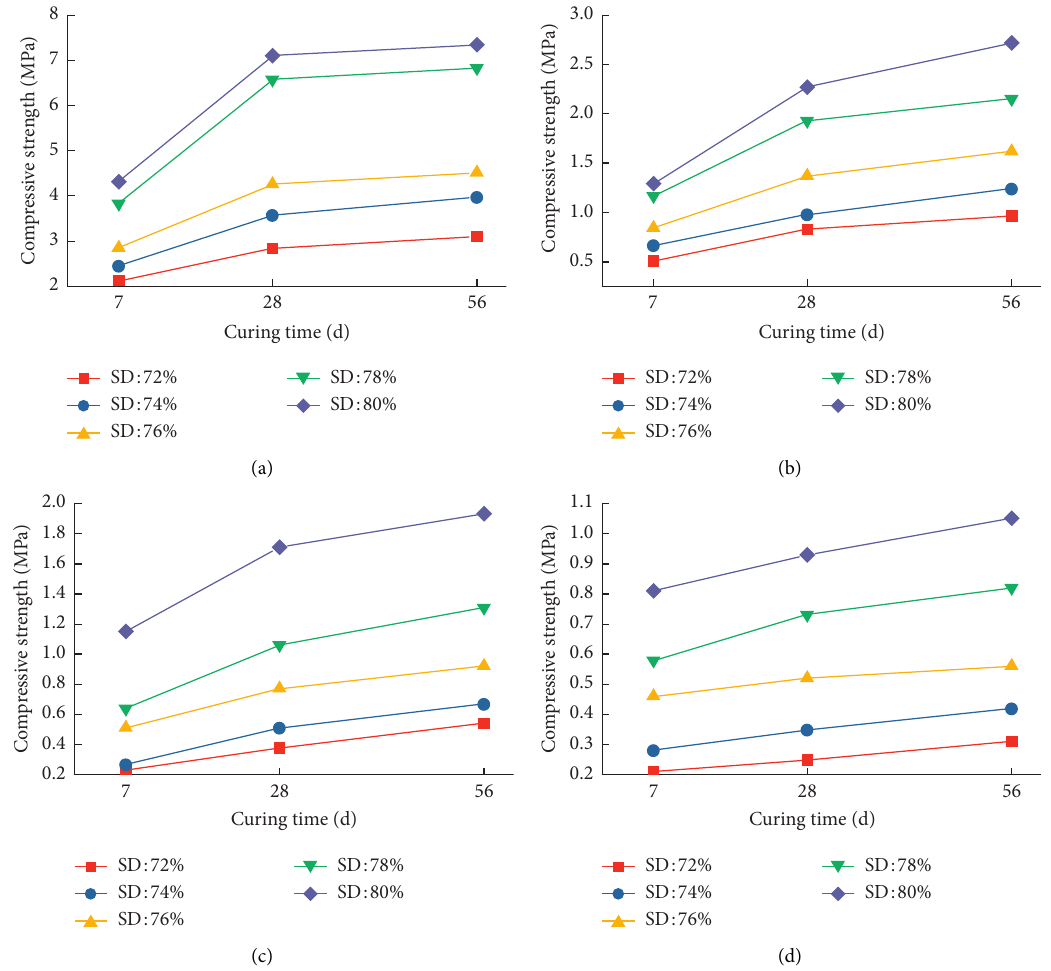
Figure 9: Relationship between CT and UCS of CUTB: (a) c/t: 1:04; (b) c/t: 1 :08; (c) c/t: 1:12; (d) c/t: